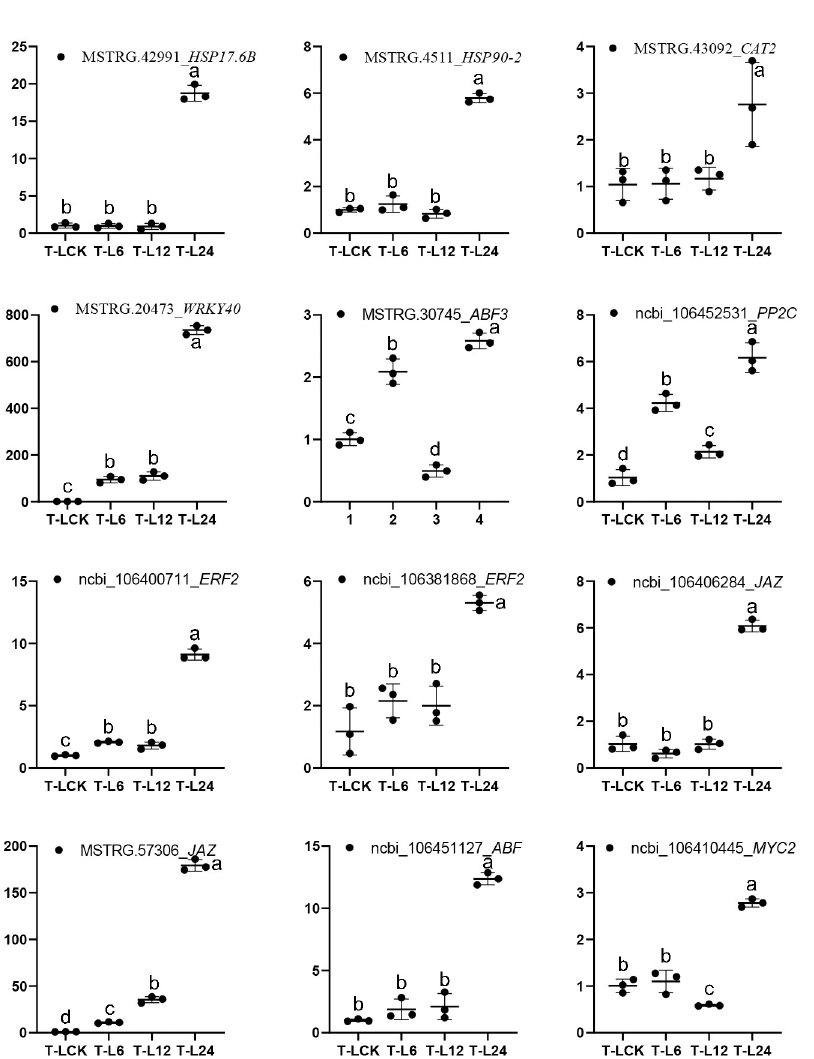
Fig 7. QRT-PCR analysis results. The range of gene expression was indicated by 2 − ΔΔ CT . Different letters represent significant differences ( p <